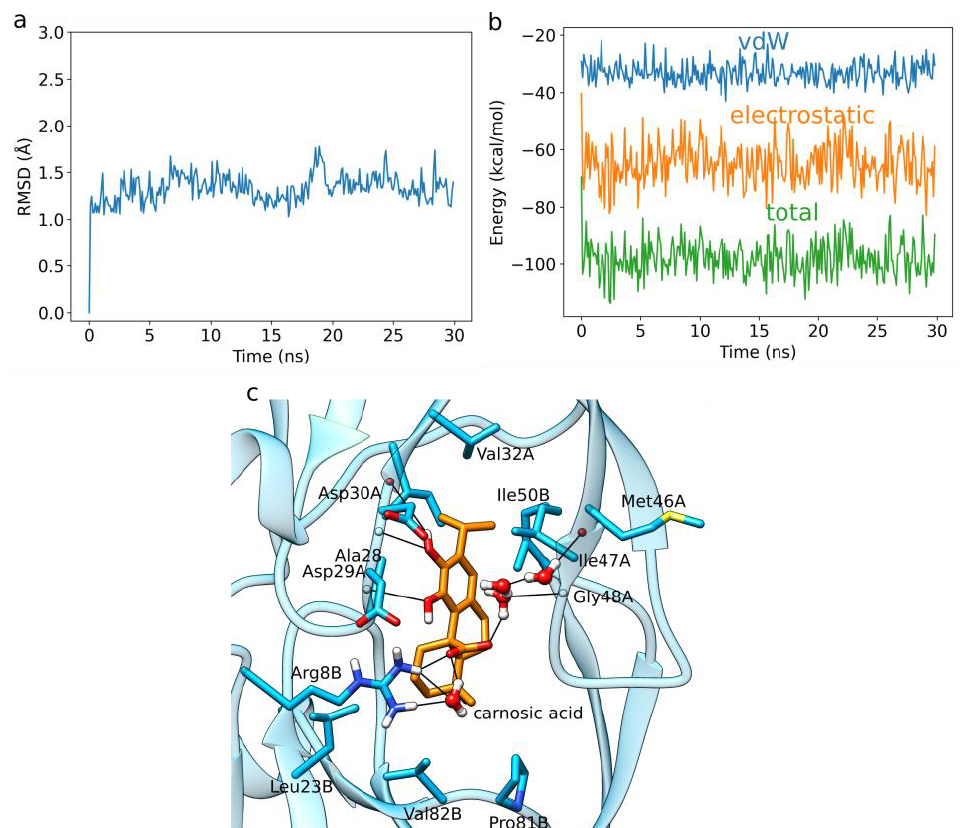
Figure 3. MD simulation of carnosic acid bound to HIV-1 protease. ( a ) RMSD of the protein backbone of the analyzed MD simulation. ( b ) Interaction energy analysis describing the binding between carnosic acid and HIV-1 protease as observed in the MD simulation. ( c ) Carnosic acid forms a stable H-bond network in the HIV-1 protease binding site. Hydrogen bonds are shown with black lines. The remaining amino-acid residues displayed with sticks form hydrophobic contacts. We show stable H-bonds and hydrophobic contacts with occupancy of at least 50%.